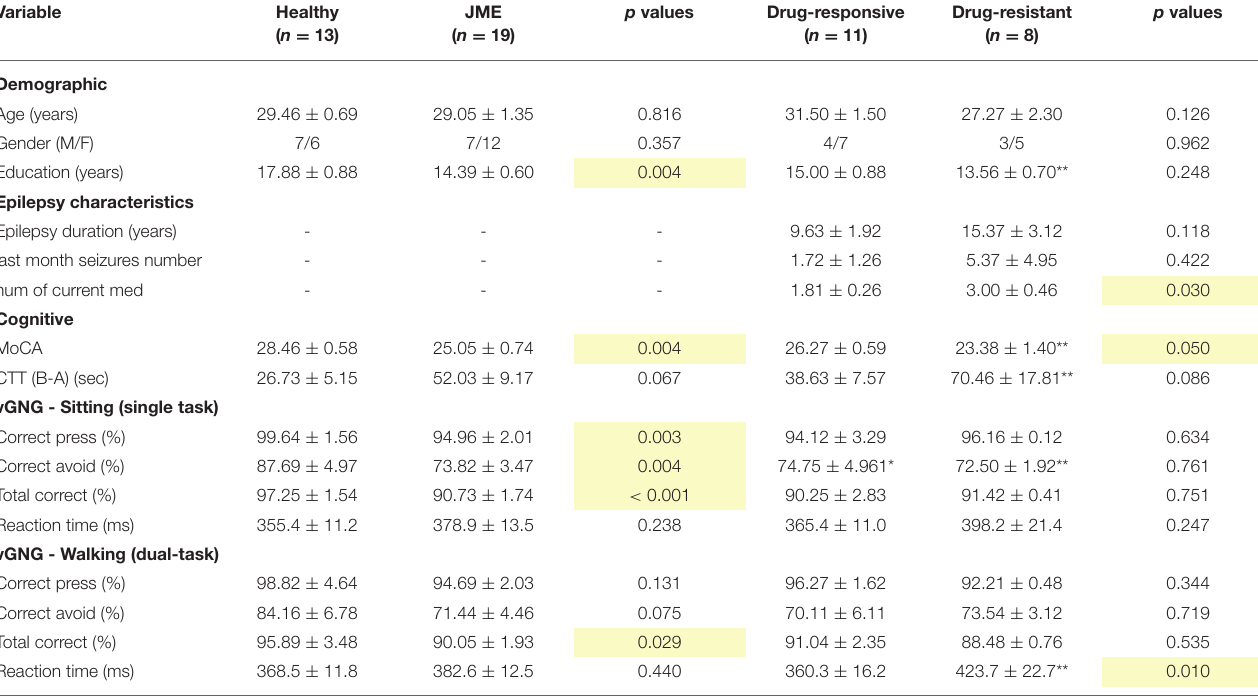
TABLE 1 | Subject characteristics, significant values are marked in yellow.